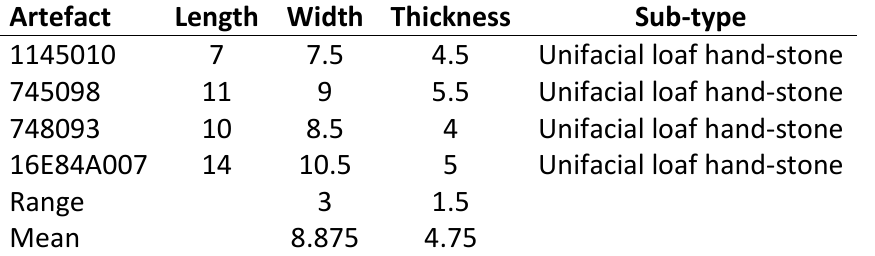
Table 4. Metric data for unifacial loaf hand-stones. Units are in centimetres and bold font indicates intact